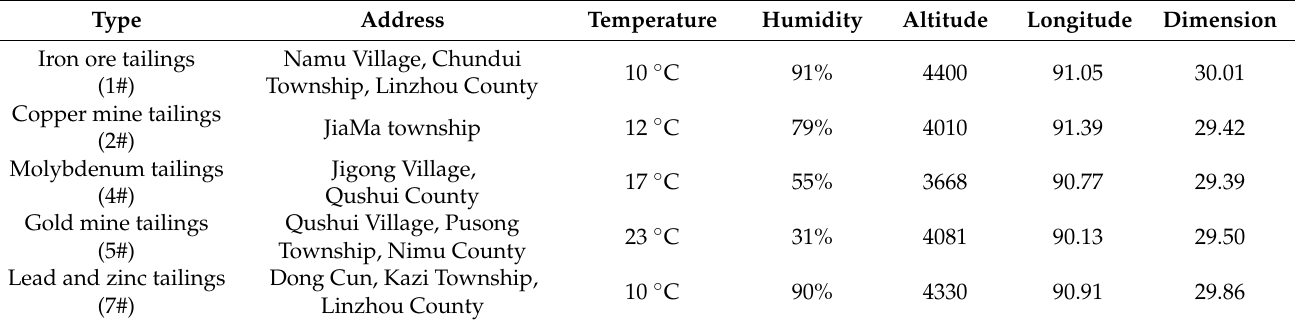
Table 1. Sampling situation of typical metal tailing pond in Tibet Autonomous Region.